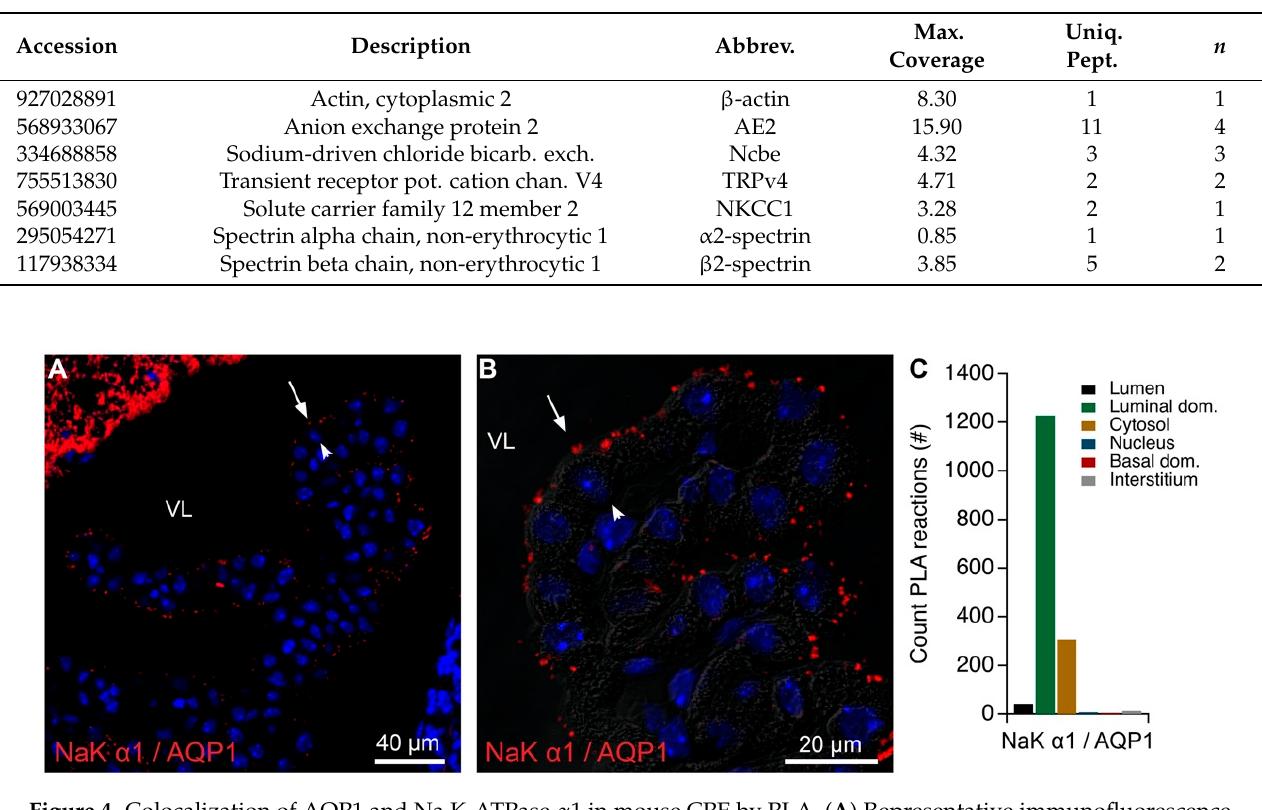
Figure 4. Colocalization of AQP1 and Na,K-ATPase α 1 in mouse CPE by PLA. ( A ) Representative immunofluorescence image of PLA products (red) using anti-Na,K-ATPase α 1 (NaK α 1) and AQP1 antibodies and cell nucleus counterstain (blue) at low magnification. ( B ) Higher magnification micrograph of the same structure overlaid on the corresponding DIC image. Arrows indicate luminal surfaces, while arrowheads mark basolateral surfaces. VL denotes the fourth ventricle lumen. ( C ) Bar graph representing the count of PLA reactions in the indicated image areas.